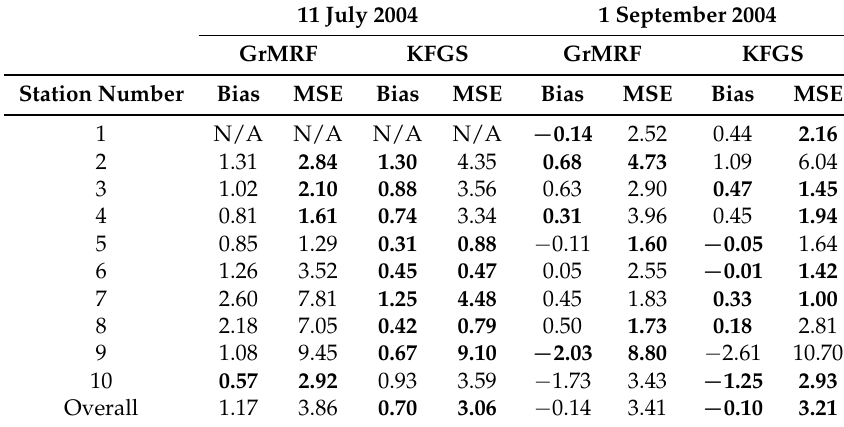
Table 2. Performance of GrMRF and KFGS in simulating the 3-hourly surface wind speed at each station during 11 July 2004 and 1 September 2004. The last row corresponds to the overall mean performance of the experiments. Bold numbers indicate the simulation with the smallest mean bias (m s − 1 ) and MSE (m 2 s − 2 ). N/A: observations not